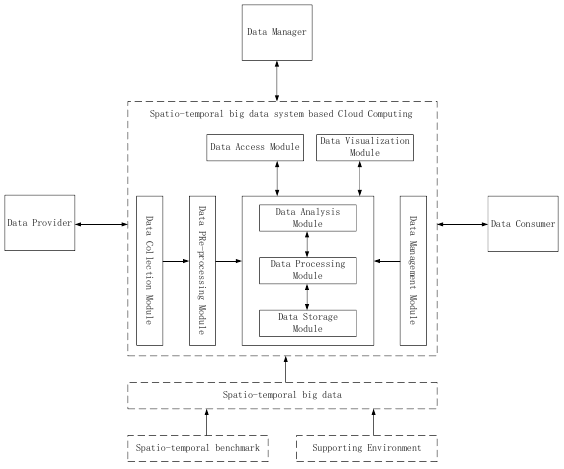
Figure 5 . Overall functional architecture of the spatiotemporal data opening and sharing